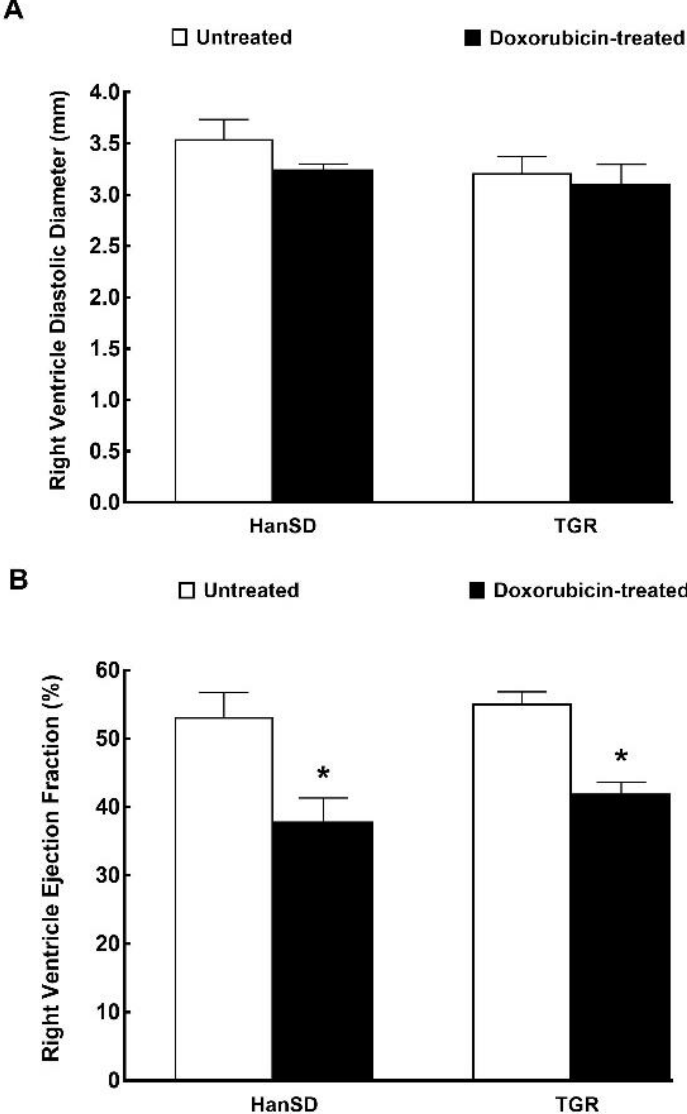
Figure 8. Right ventricle function. Assessment of the right ventricle diastolic diameter ( A ) and right ventricle ejection fraction ( B ) by echocardiography after the last doxorubicin injection (i.e., at the end of the experimental protocol) in normotensive, transgene-negative Hannover Sprague-Dawley (HanSD) and hypertensive, Ren-2 transgenic (TGR) rats. * p < 0.05 compared with untreated animals of the same strain. The values are means ± SEM.